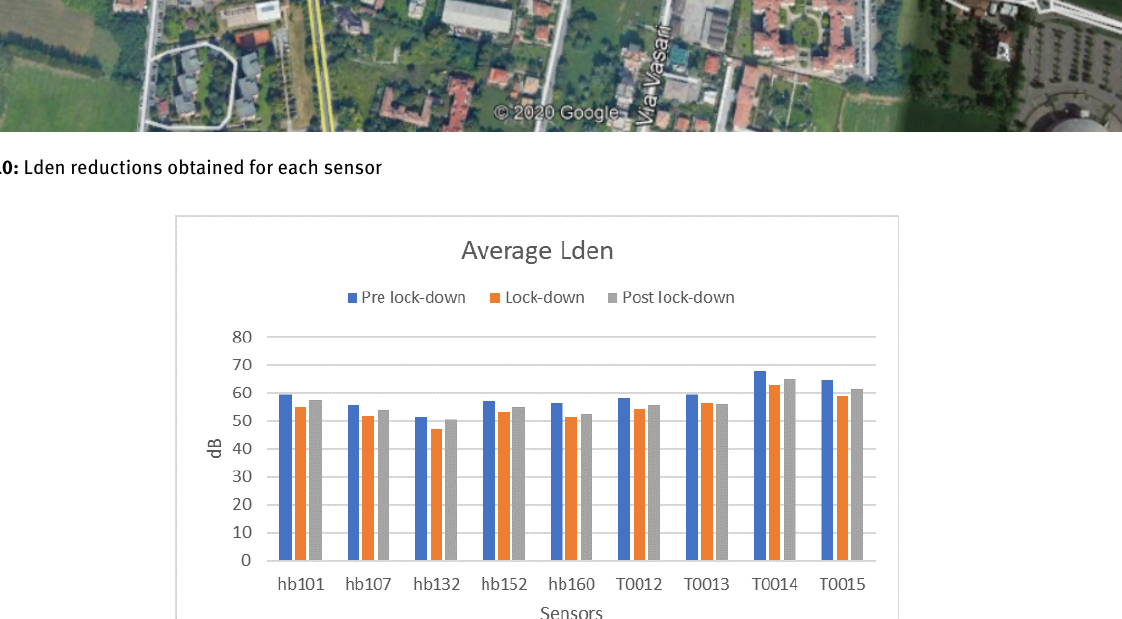
In Figure 10, the noise level reduction evaluated ac- cording to the Lden parameter as difference between the first week of January and the last week of April is reported for each sensor. Lden reductions are comprised between 6.1 dB and 10.3 dB.